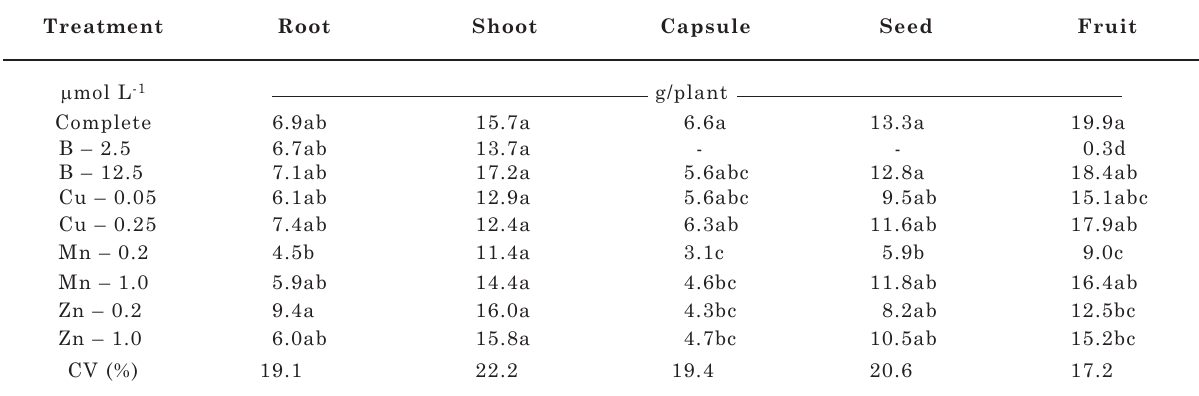
table 1. Dry matter yield of the parts of the castor bean hybrid “iris”, grown in a complete nutrient so- lution and with different levels of b, cu, mn and Zn treatment root Shoot m mol L